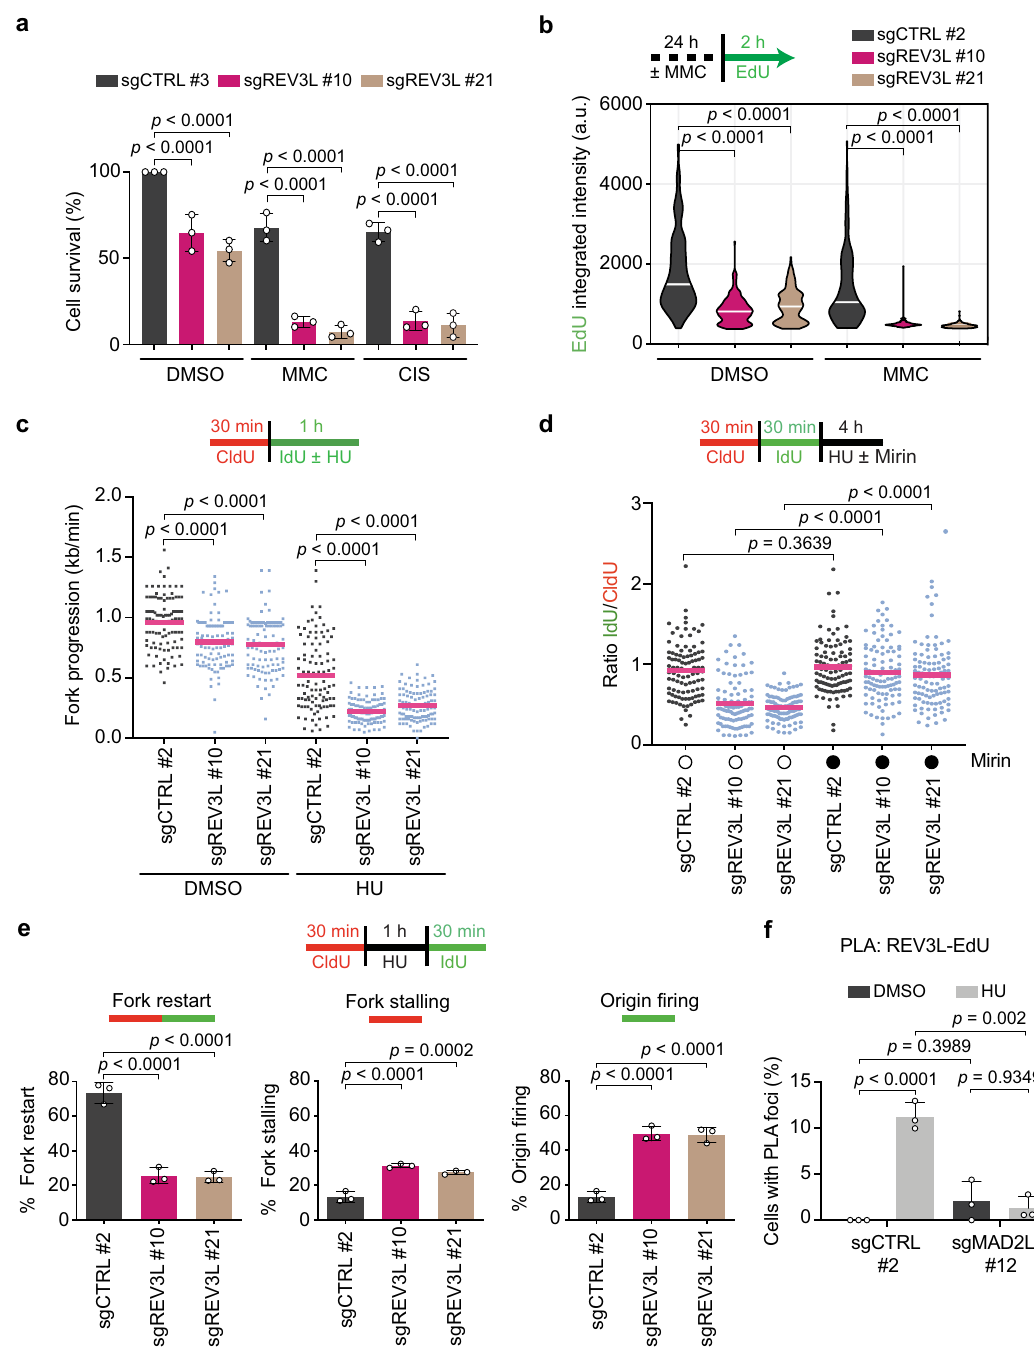
Fig. 5 | REV3L is essential to protect and restart stalled replication forks. a Quanti fi cation of survival assays in control (sgCTRL) and REV3L-depleted HeLa cells, untreated or treated with 0.5 μΜ MMC or 1 μΜ CIS. Bars represent the mean±SD. Each dot represents one of three independent experiments. b Schematic and quanti fi cation of EdU incorporation intensity in control and REV3L-depleted HeLa cells. Cells were incubated with or without 5 μΜ MMC for 24h, followed by EdU labeling for 2h before harvesting. White bars represent the median of three independent experiments. c Schematic and quanti fi cation of fork progression assays in control and REV3L-depleted HeLa cells, untreated or treated with 4mM HU for 1h. A representative fi ber experiment from two independent biological replicates is shown. d Schematic and quanti fi cation of fork degradation assays.ControlandREV3L-depletedHeLacellsweretreatedwith4mMHU±50 μΜ mirinfor4h.Opencircles,notreatment;closedcircles,treatment.Arepresentative fi ber experiment from three independent biological replicates is shown.